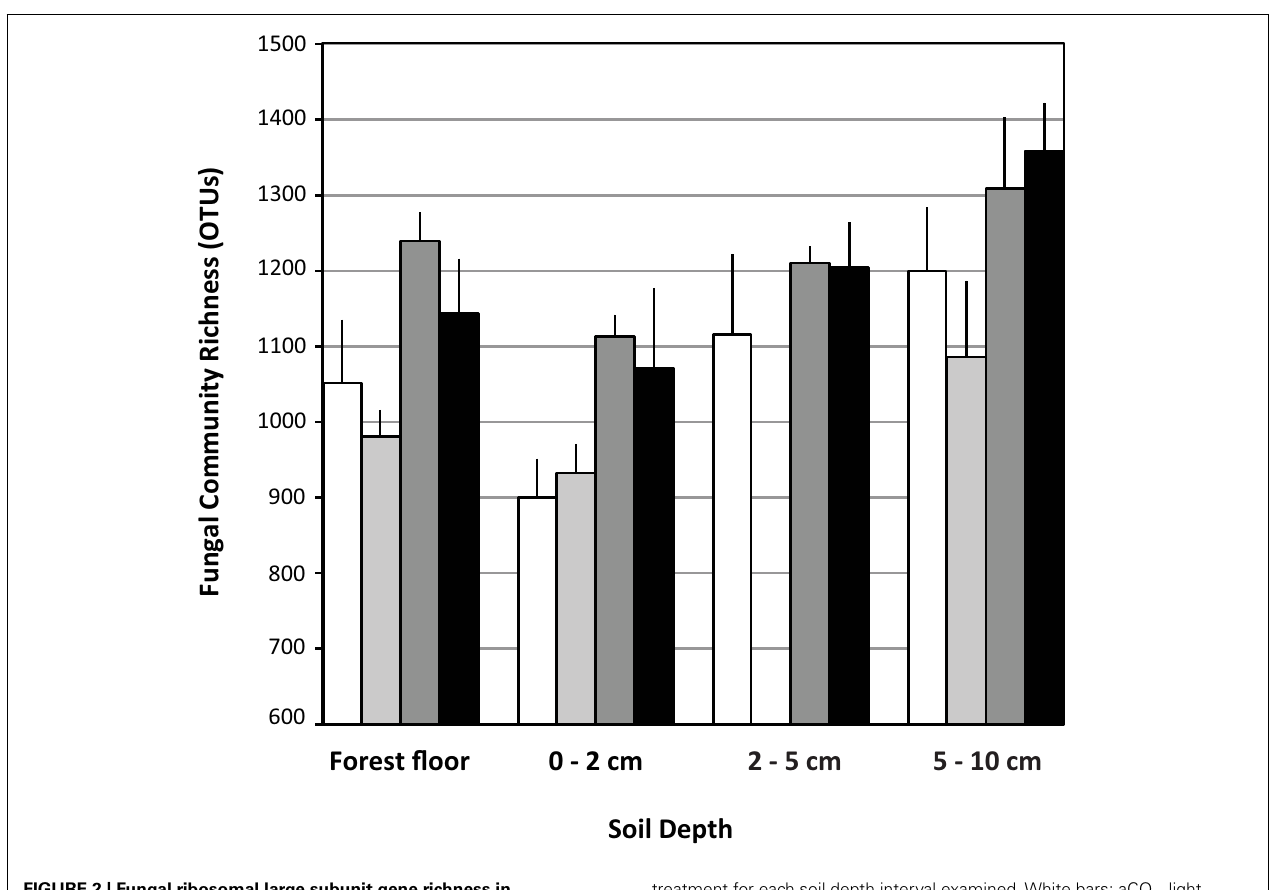
FIGURE 2 | Fungal ribosomal large subunit gene richness in libraries (OTU = 97% sequence similarity). Data are means with standard deviation of richness in three pyrotag libraries per field